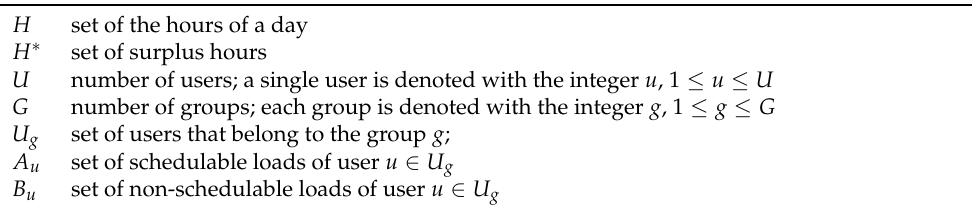
Table 1. Sets of the optimization model.